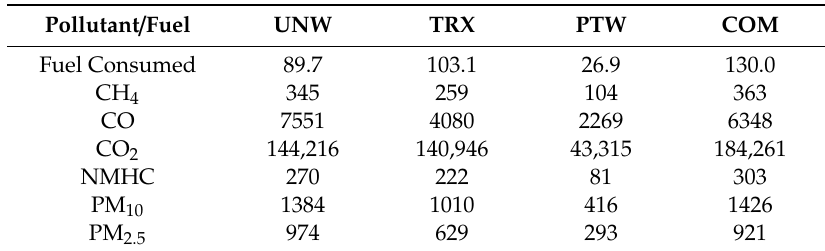
and mean total fuel consumed, in megagrams per